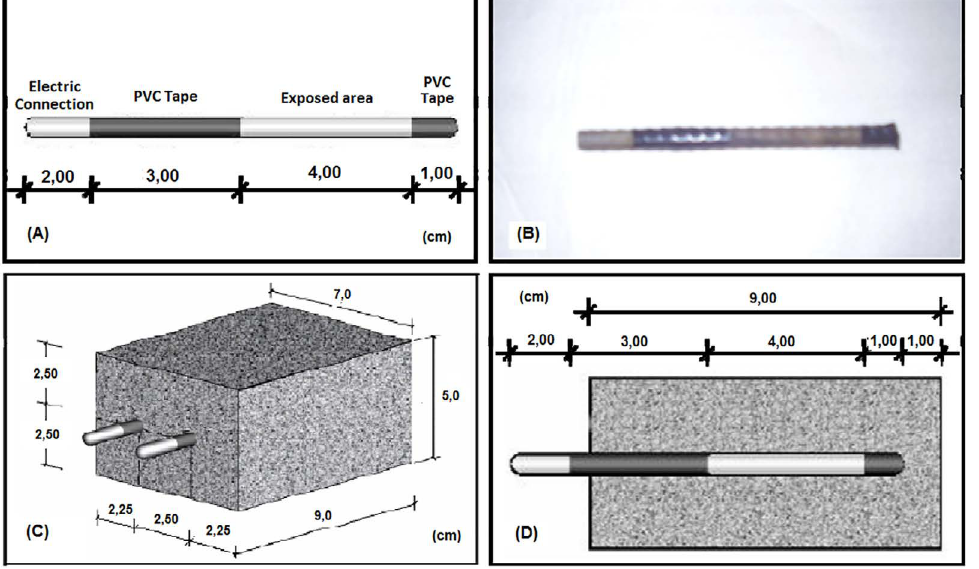
Figure 3. (A) and (B) Scheme of delimitation of the bars exposed area; (C) and (D) Position of bars inside the concrete specimen (RIBEIRO